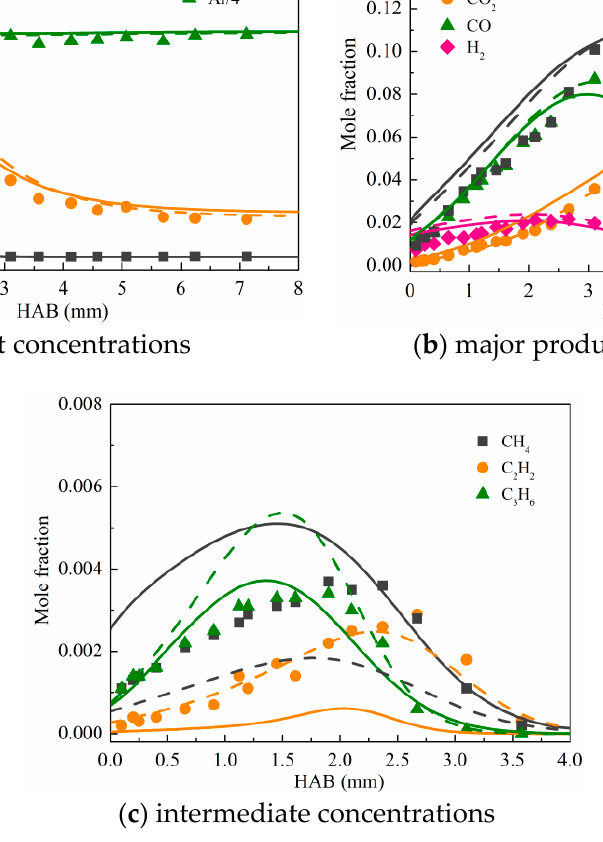
Figure 11. Measured (symbols) [16] and calculated (lines) species concentrations in premixed MTHF2 flames at φ = 1.0. Solid lines: reduced diesel/MTHF2 mechanism; dashed lines: detailed MTHF2 mechanism [17].